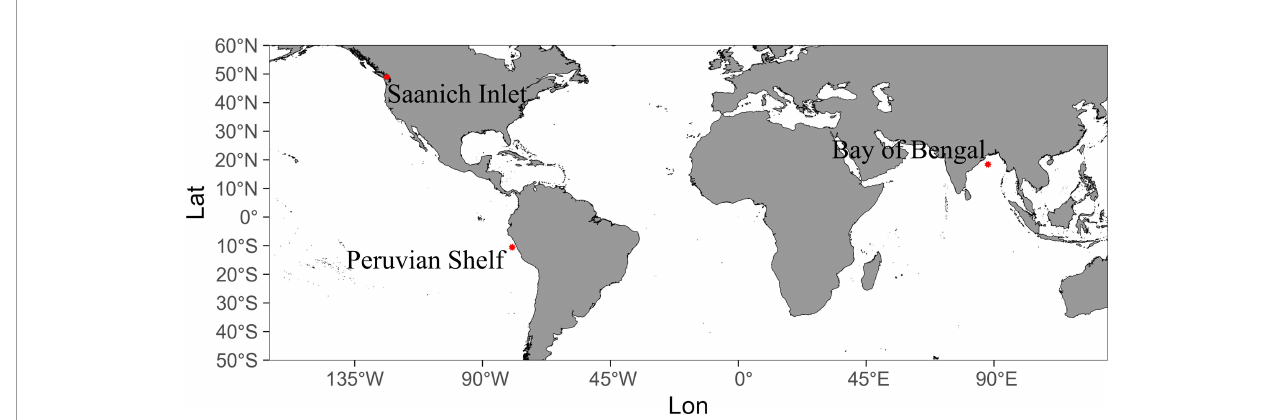
FIGURE 1 | Location of stations from where samples were analyzed from. Stations are indicated by a red star. Peruvian Shelf at 12.2°S, 77°W. Saanich inlet at 48.5°N, 123.5°W. Bay of Bengal at